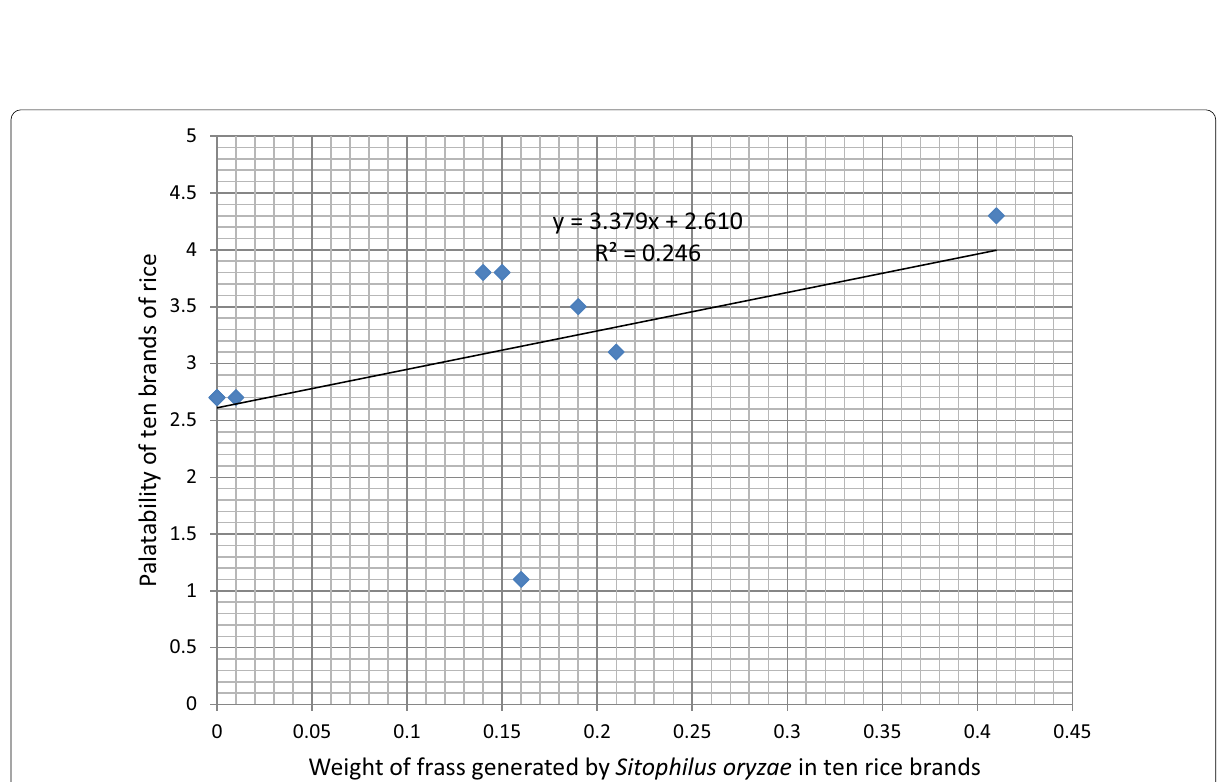
Fig. 3 Association between rice brand palatability and weight of frass generated by Sitophilus